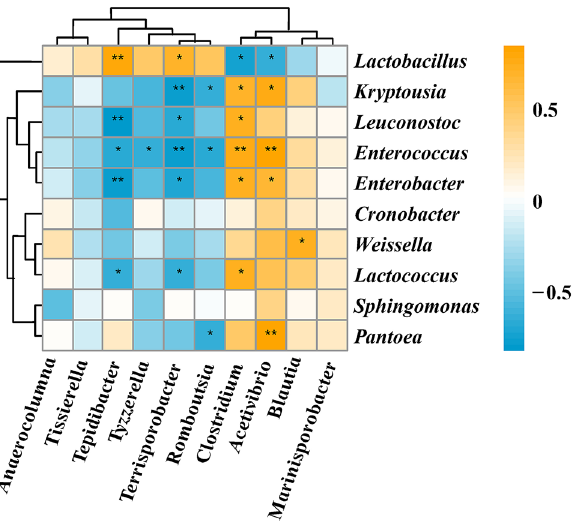
Figure 8. Spearman correlation analysis heatmap between the genera of single clostridia and other bacteria; **highly significant correlation at the 0.01 level; *highly significant correlation at the 0.05